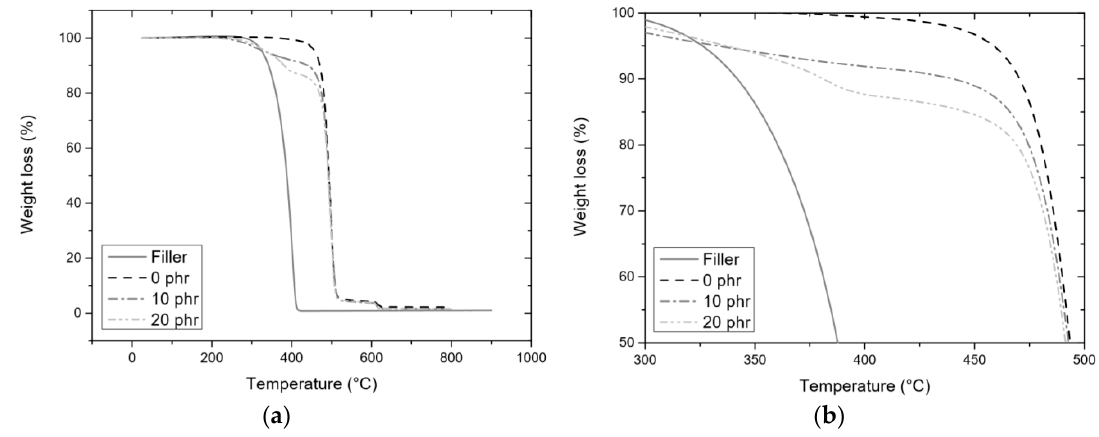
Figure 9. Thermal Gravimetric Analysis (TGA) curves of POSS-F filler and F TF nanocomposites at different filler loading under nitrogen. ( a ) unzoomed; ( b ) zoomed.